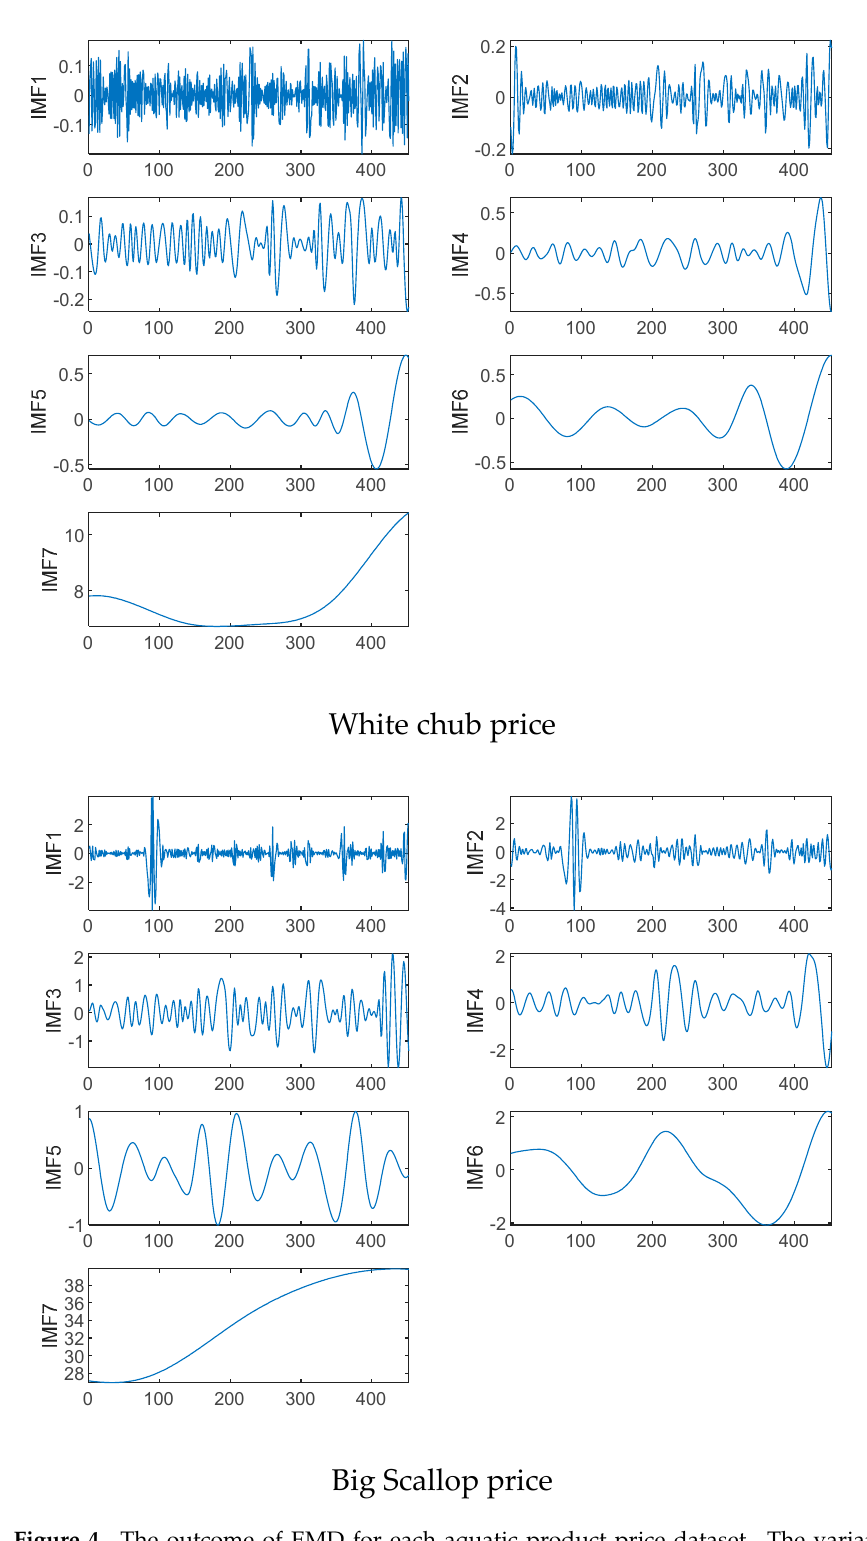
Figure 4. The outcome of EMD for each aquatic product price dataset. The variational modal decomposition (VMD) results for each dataset are shown below.